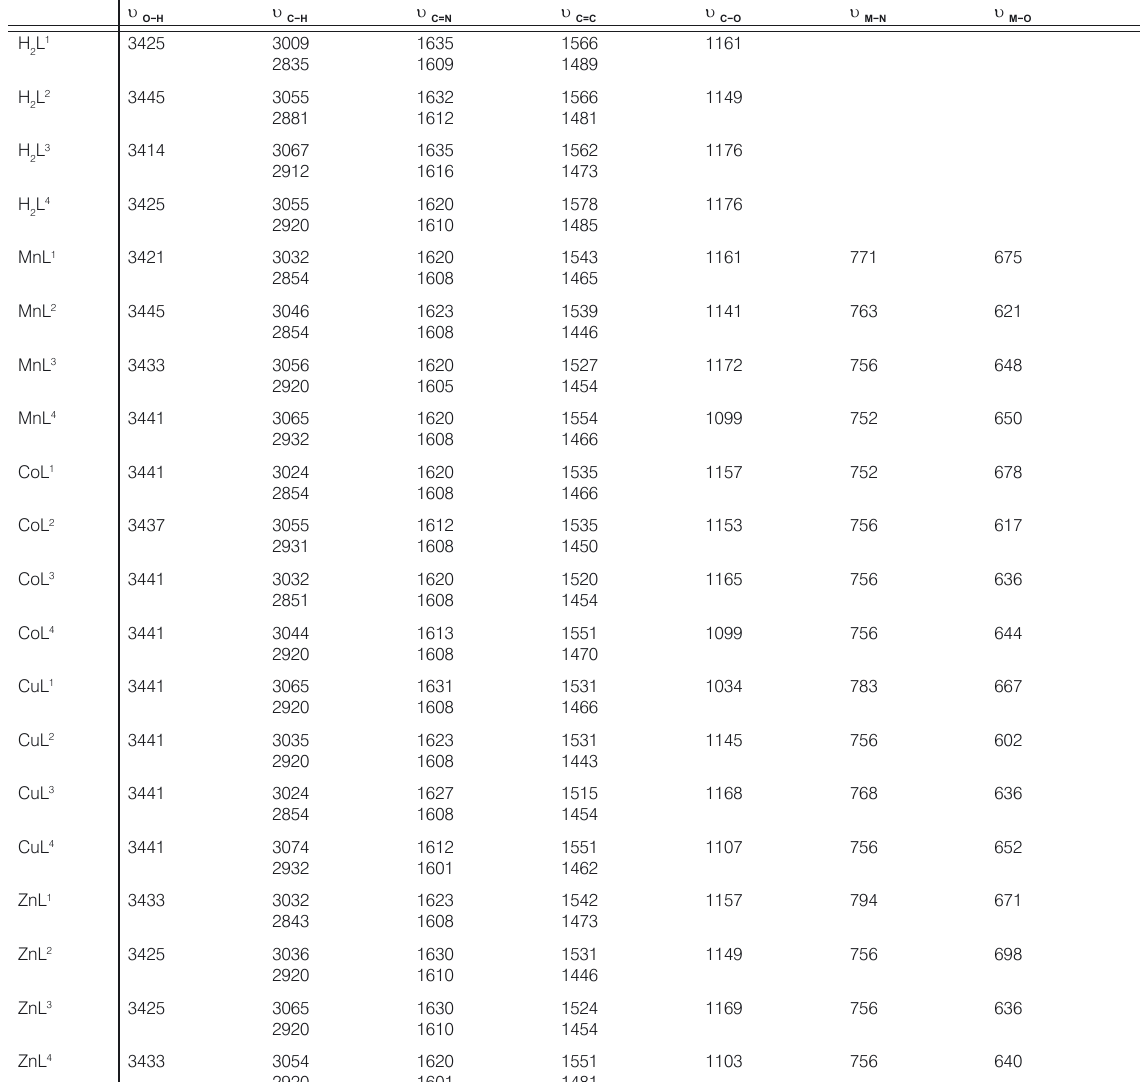
Table 4. Important IR spectral bands (cm -1 ) and their